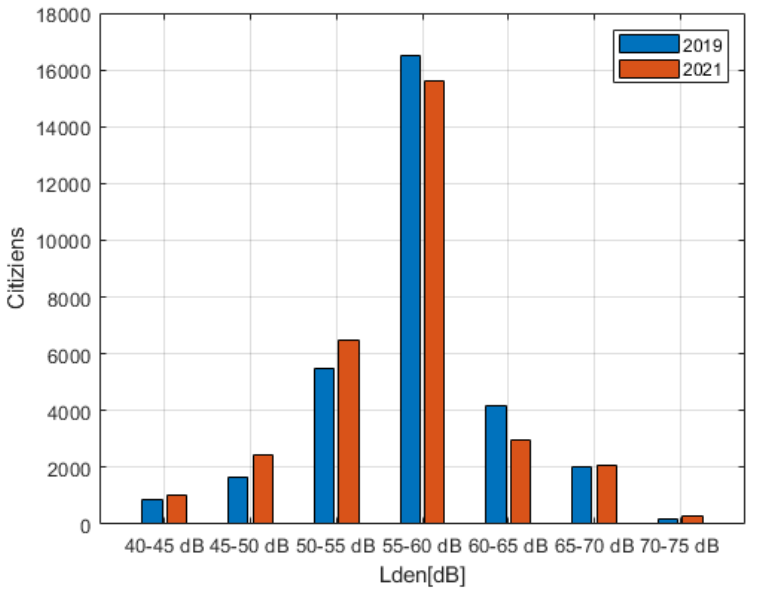
Figure 17. Population exposed to L den exposure categories for both 2019 and 2021.